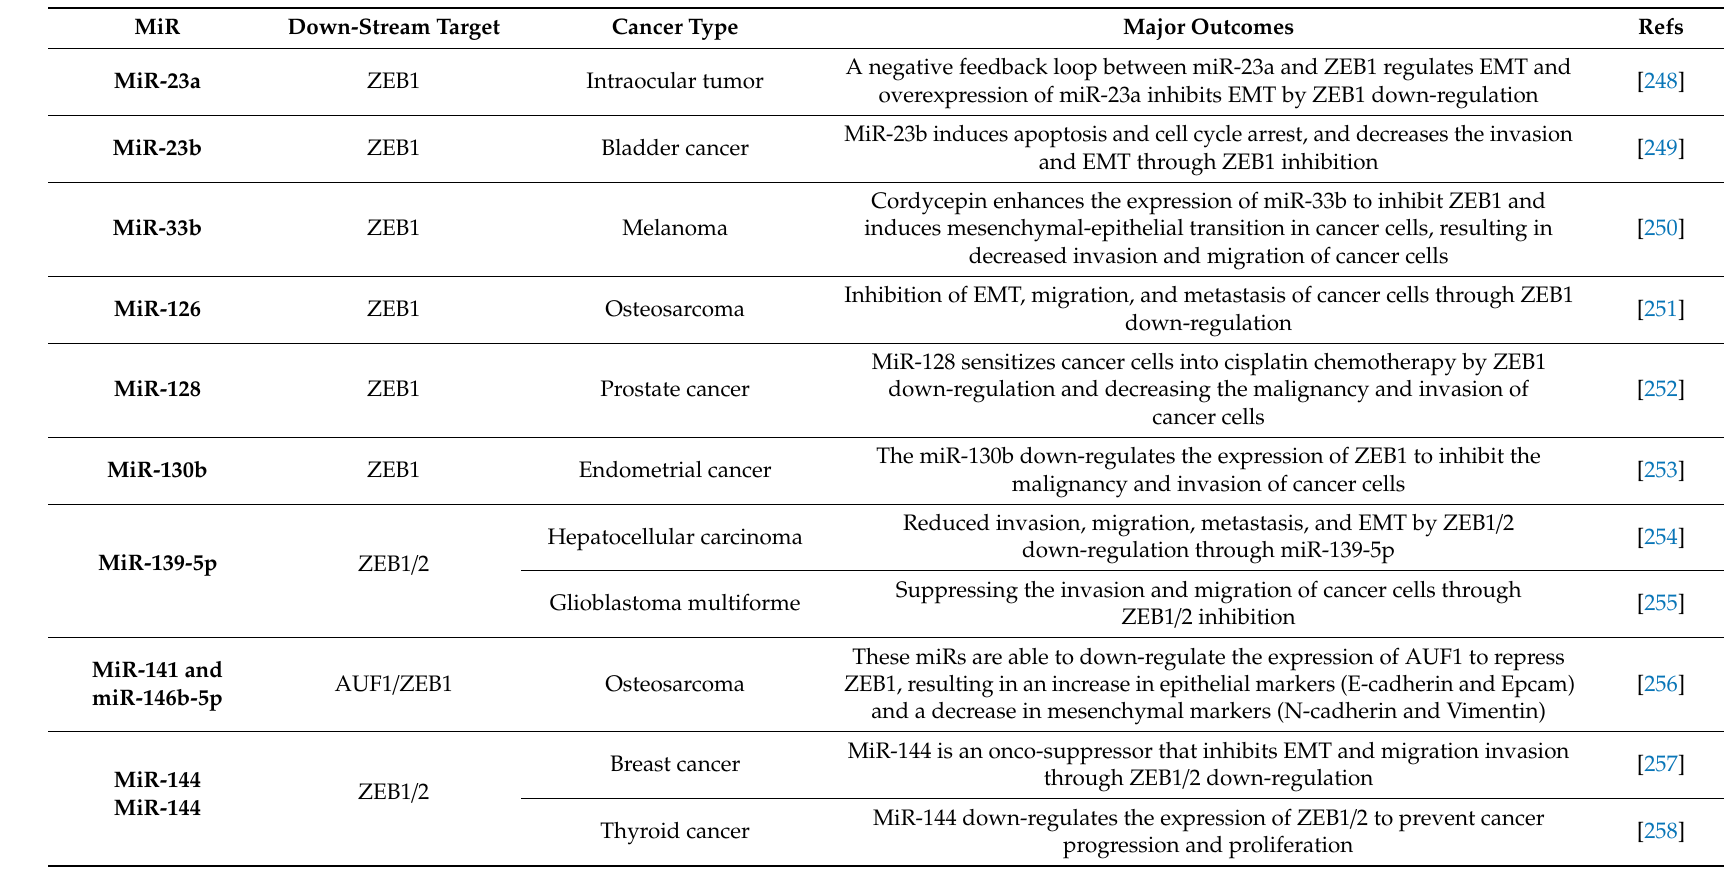
Table 1. ZEB1 regulation by miRs in di ff erent